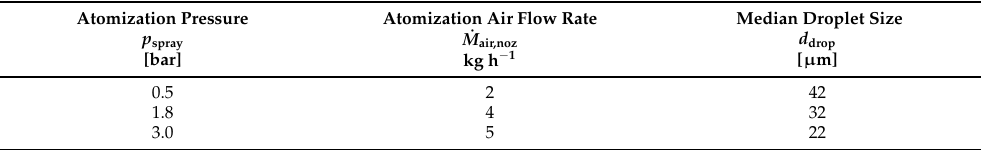
Table 5. Measured nozzle air flow and droplet size resulting from varying the atomization pressure.